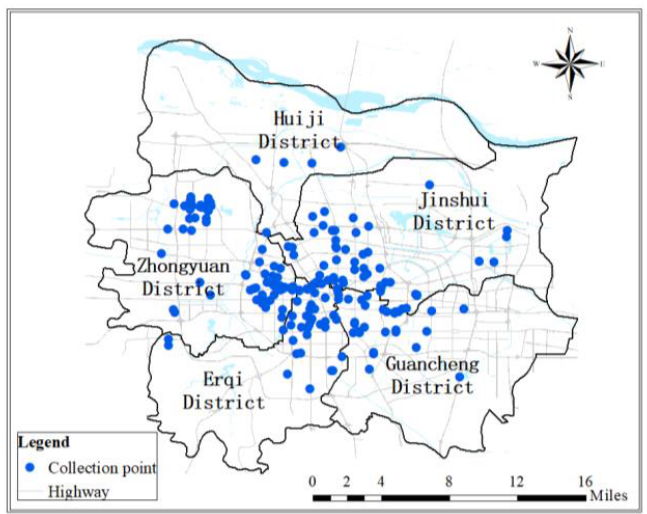
Figure 3. Location distribution of survey objects.